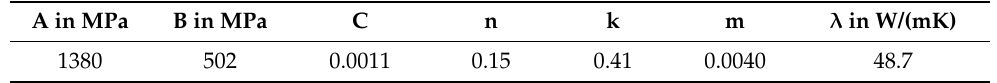
Table 3. Parameters used for the Johnson–Cook model from Schmitz et al. [4].